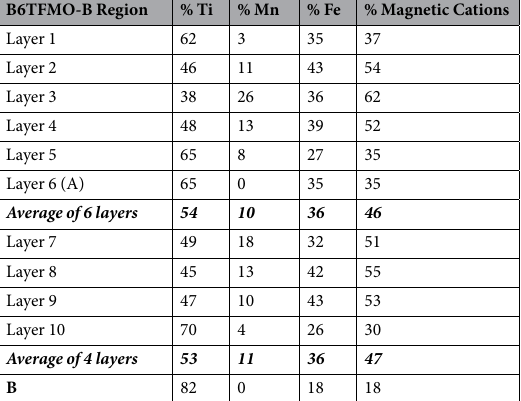
0.70, 0.46 and 0.05 respectively for the O , M and C layer octahedra (Fig. 1(a)). These are much smaller than the values reported for Bi